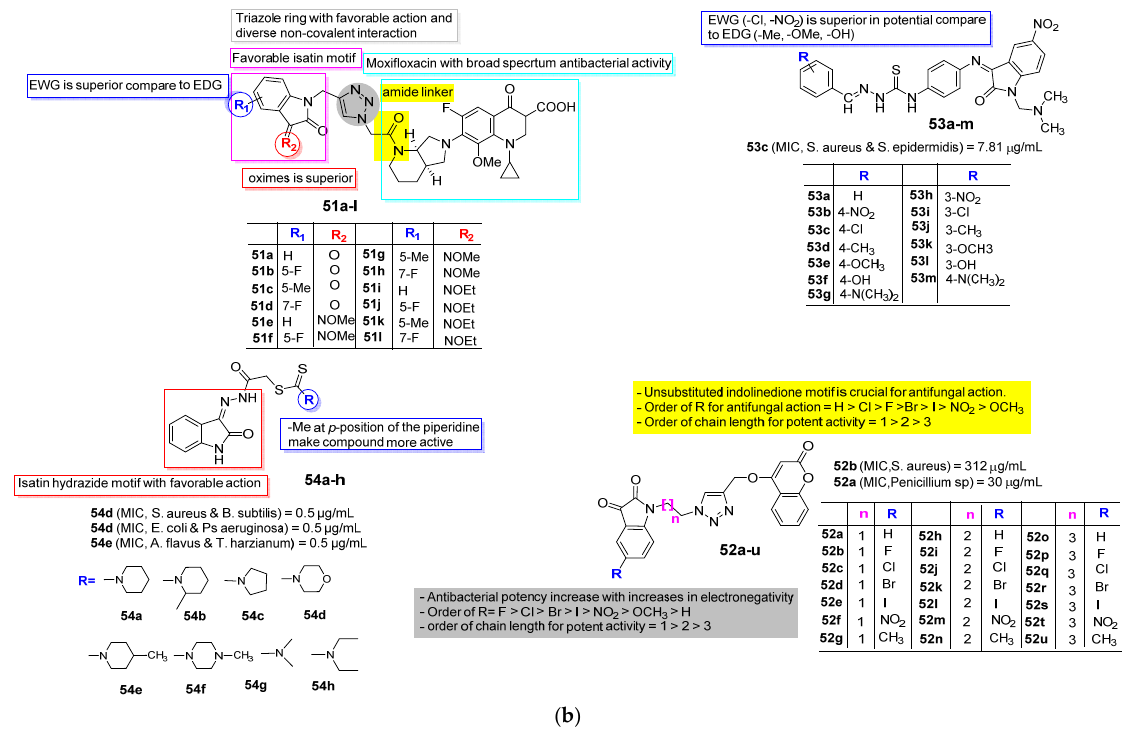
Figure 5. ( a ) SAR features contributing to antimicrobial potential of some isatin analogues. ( b ) SAR features contributing to antimicrobial potential of some isatin analogues.